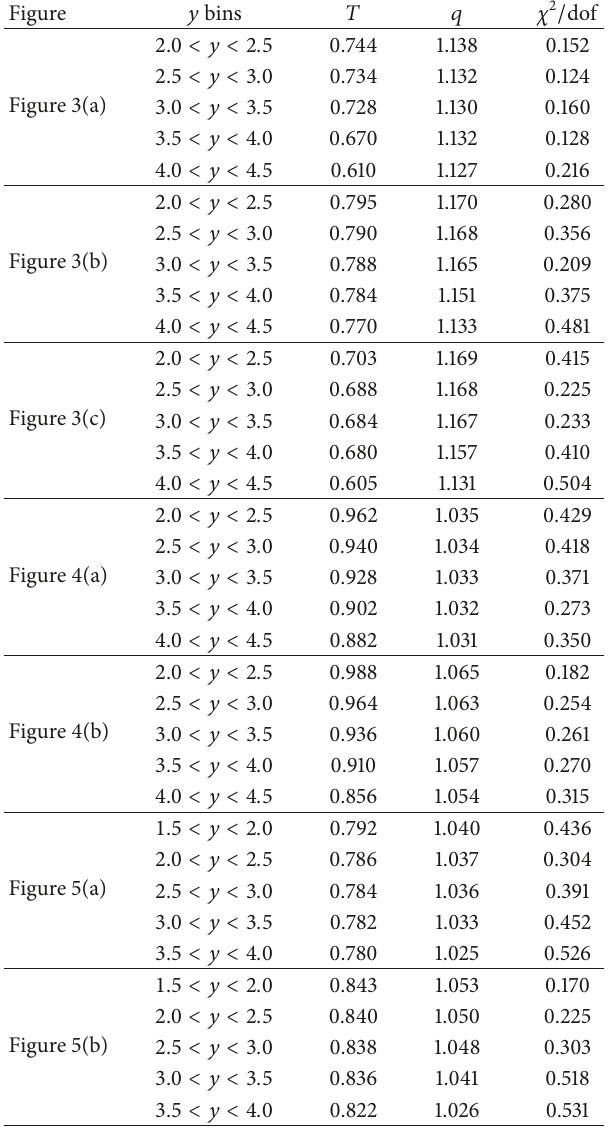
Table 2: Values of 𝑇 and 𝑞 used in Figures 3–5.